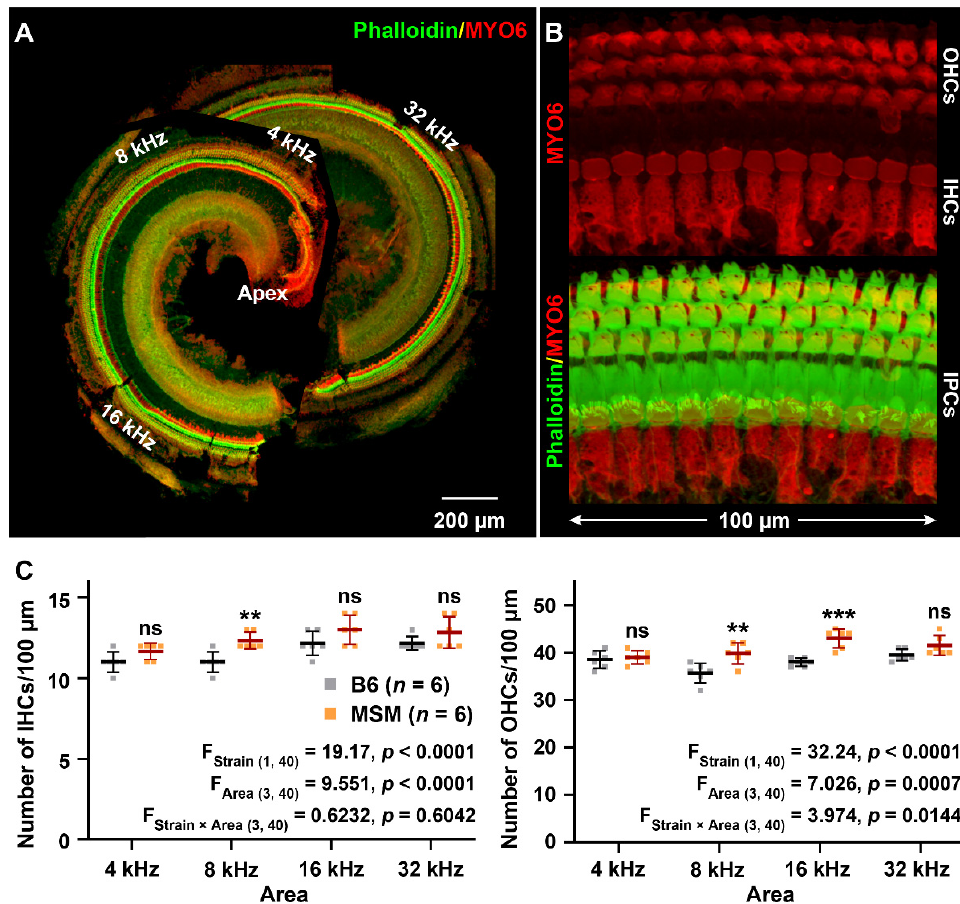
Figure 2. Counts of the inner hair cells (IHCs) and outer hair cells (OHCs) of B6 and MSM strains: ( A , B ) Confocal images of the cochlea and hair cells from the basal area in B6 strain at 2 months of age immunostained with anti-MYO6 antibody (red) and phalloidin (green). Cochlear hair cells were observed at the 4, 8, 16, and 32 kHz-corresponding areas and OHCs and IHCs were counted within 100 μ m in this study. Inner pillar cells (IPCs). ( C ) Counts of the IHCs and OHCs within 4, 8, 16, and 32 kHz-corresponding areas of the cochlea from male mice of the B6 and MSM strains at 2 months of age. The means (middle bars) and SDs (error bars) of the number of IHCs and OHCs are shown in each graph. The square dots represent the number of cells of individual mice. The data used for the statistical analyses by two-way ANOVA are provided in the graphs for each strain and area ( B ). The asterisks and “ns” symbols indicate the presence of significant (** p < 0.01 and *** p < 0.001) and no significant differences, respectively, in the numbers of IHCs (left) and OHCs (right) between male B6 and MSM strains in the same area, determined using Sidak’s (IHCs) and Tukey’s (OHCs) multiple comparison tests after two-way ANOVA.